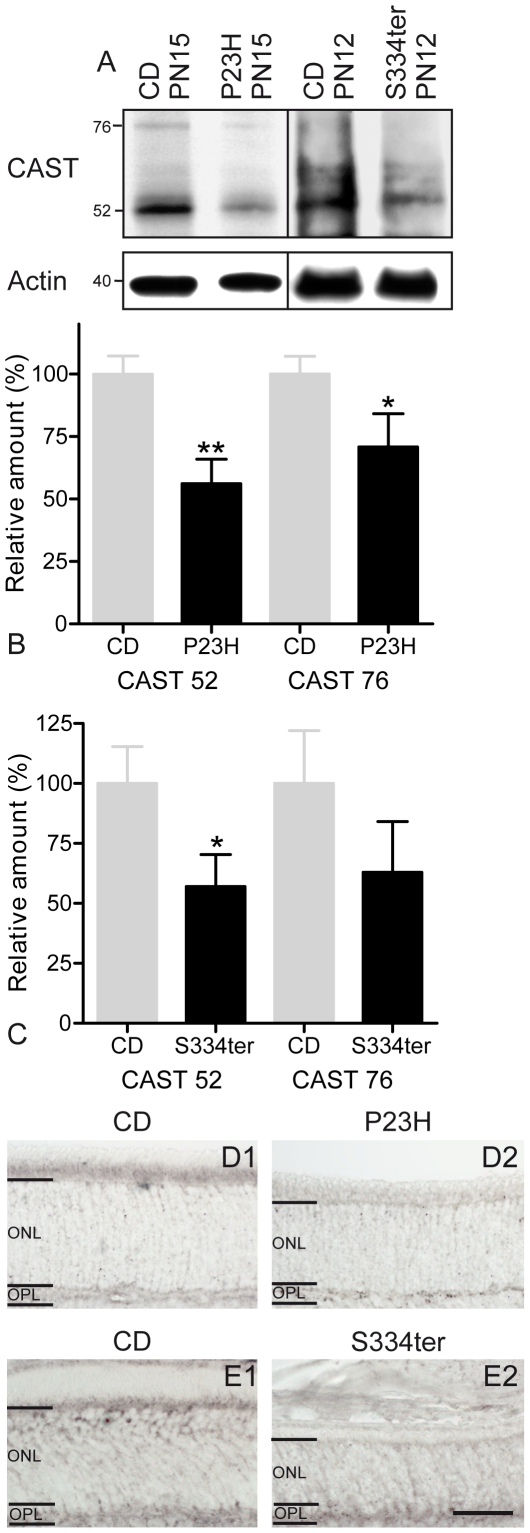
Expression of calpastatin in rhodopsin transgenic rats.(A) Immunoblotting for calpastatin showed decreased levels in both, P23H and S334ter rats. (B–C) Quantification of the main calpastatin bands at 76 and 52 kDa showed decrease expression in both mutant retinas. This decrease in expression was statistically significant for both bands in (B) P23H retina and (C) for the 52 kDa band in S334ter retina. Values are mean ± SD from three different experiments each containing retinas from 6 animals. (D–E) Calpastatin staining was less intense in inner segments in both rhodopsin transgenic rats. *P<0.05; **P<0.01. Scale bar = 50 µm.